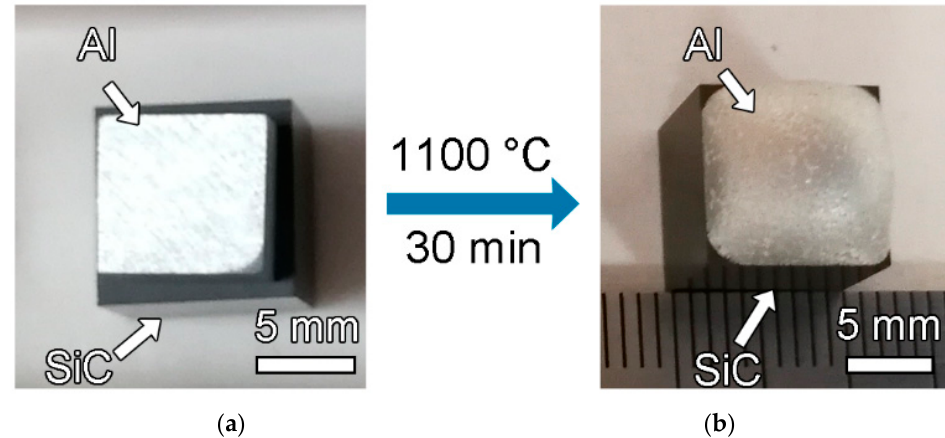
Figure 1. Photos showing ( a ) placement of 0.7 g Al alloy on SiC block before heating and ( b ) the sample after the completion of the bonding process.